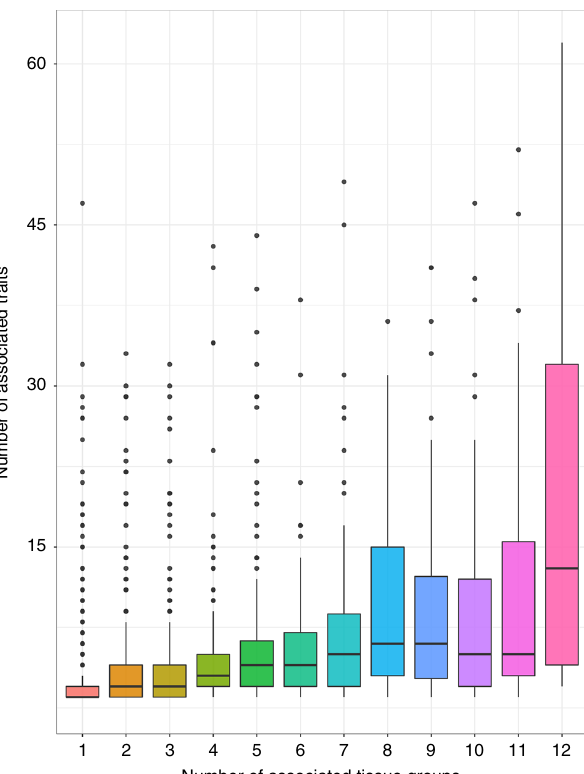
Fig. 2 Box plot depicting the trend of gene expression in multiple tissues against pleiotropy. Box plot portraying the correlation in our atlas that genetically determined gene expression is more likely to be associated with multiple traits when expressed across multiple diverse tissue types. Whisker portray maximum and minimum values, whereas bounds of the boxes represent 25 and 75% quantiles and the centre lines the median